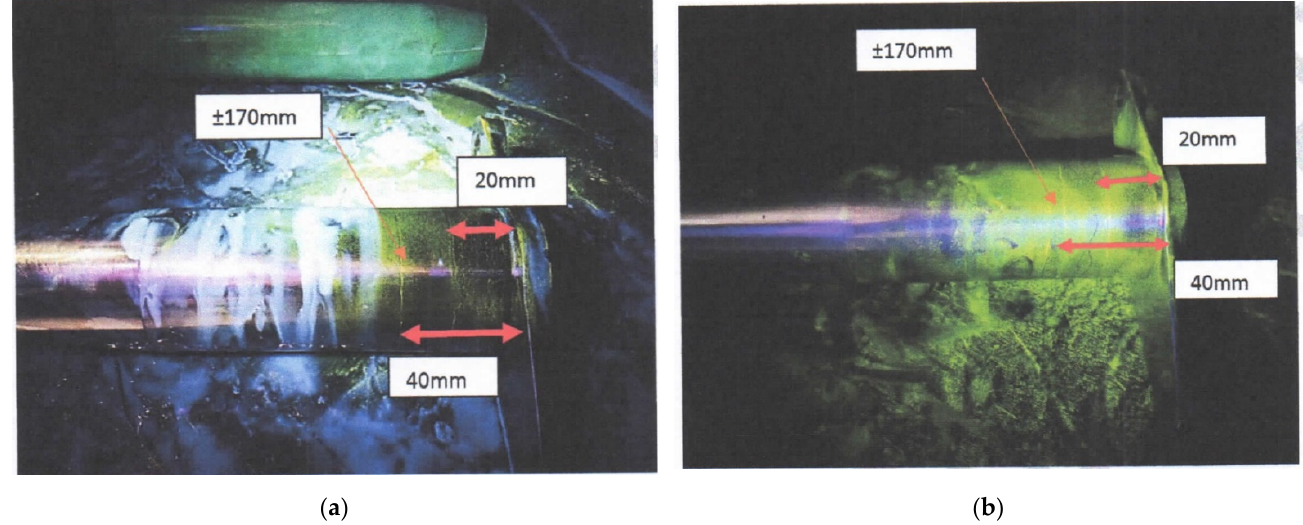
Figure 4. Discontinuity detection by the MPI method. ( a ) LH engine mounting (MPI). ( b ) RH engine mounting (MPI).